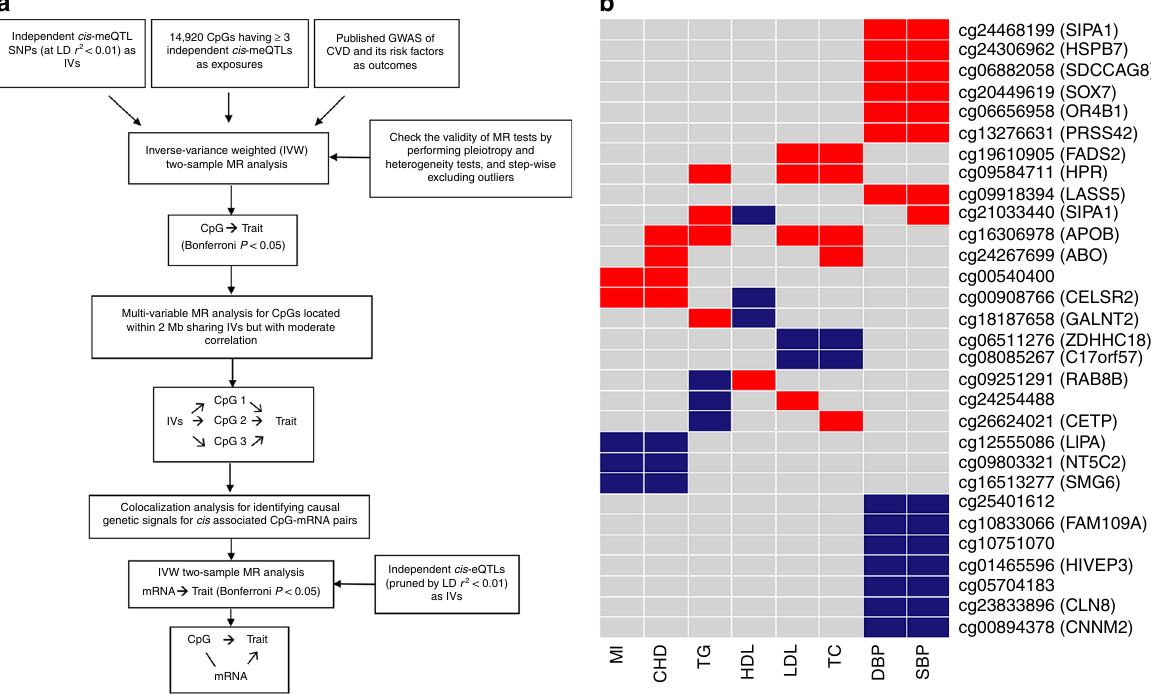
Fig. 5 Mendelian randomization analysis using cis- meQTLs as causal anchors. a Analysis work fl ow; b Heatmap of 30 CpGs causal for more than two CVD risk factors. The red color shows positive directional effects and the blue color shows negative directional